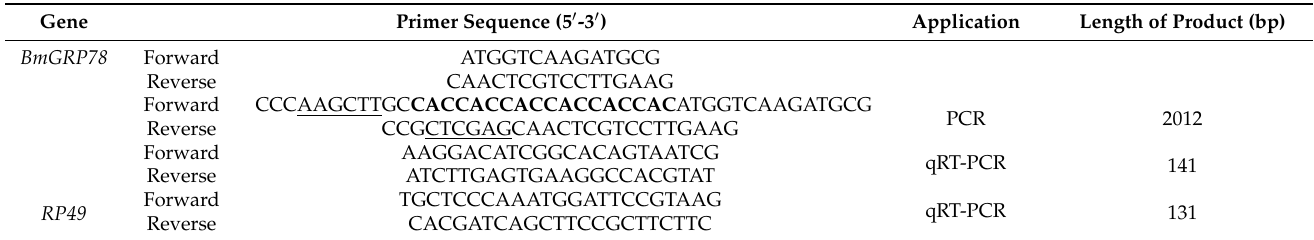
Table 1. Primer sequences used for gene cloning and verification in this study. Primer Sequence (5 (cid:48) -3 (cid:48)